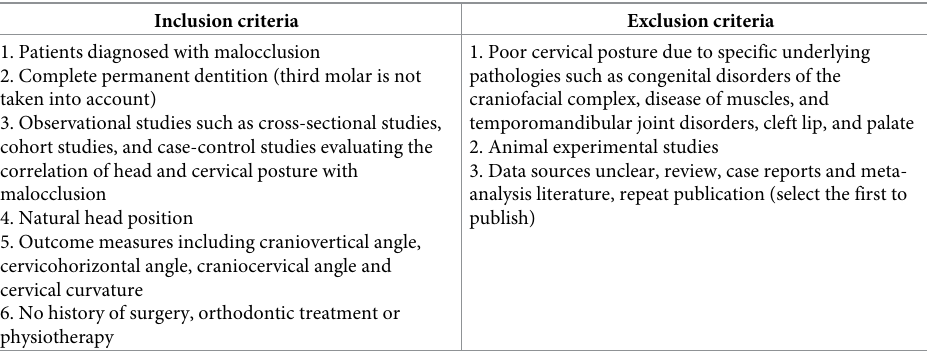
Table 1. Eligibility